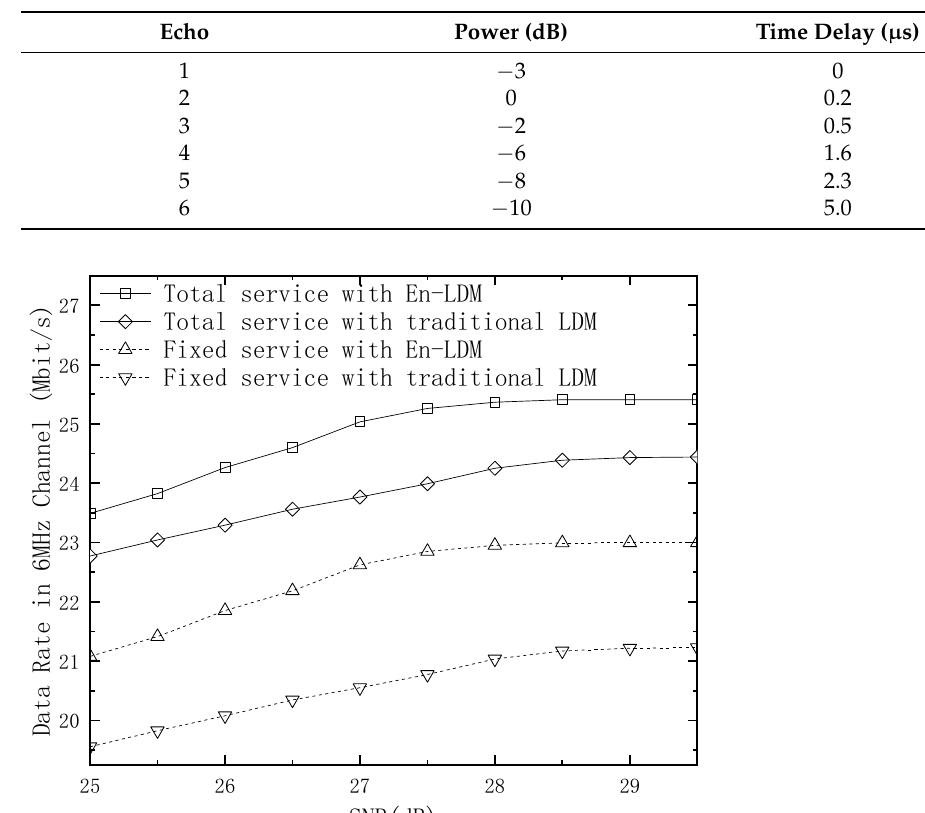
Figure 6. Channel capacity of fixed service and total service of En-LDM and traditional LDM systems under the multipath channel, where the injection level was set to ∆ = 10 dB, the CL constellation was set to QPSK, the EL constellation was set to NU − 64QAM, the puncturing rate of En-LDM scheme was set to 1/13, and the low-density parity-check (LDPC) code rates of CL and EL were set to 5/15 and 11/15, respectively.